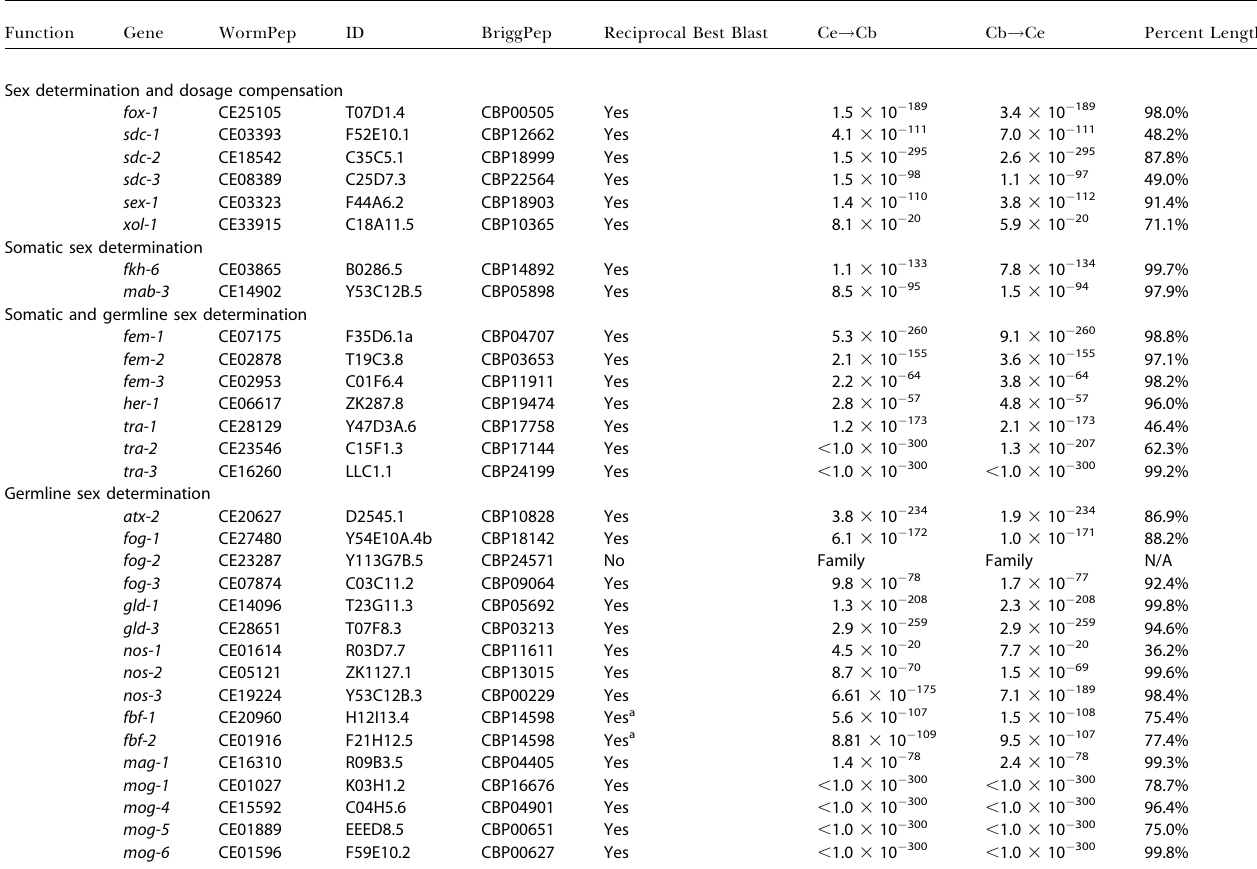
Table 1. Comparative Analysis of Sex Determination Genes in C. elegans and C. briggsae Function Gene WormPep Sex determination and dosage compensation